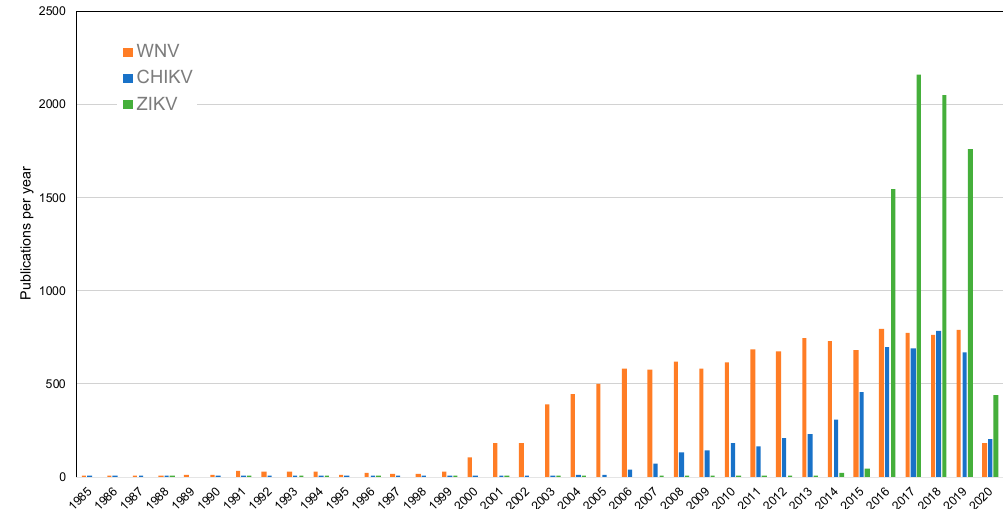
Figure 3. Results of a Basic Search of the Web of Science Core Collection for West Nile virus (WNV), chikungunya virus (CHIKV), and Zika virus (ZIKV), from 1985 to 2020. Publications in 2020 are